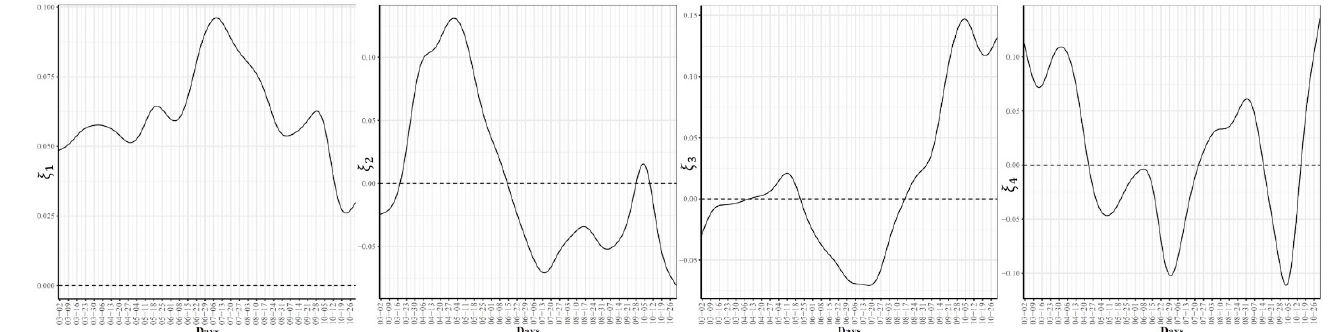
Figure 16. First four eigenfunctions of the state-level trajectories for the Google daily searches for hypoxemia.